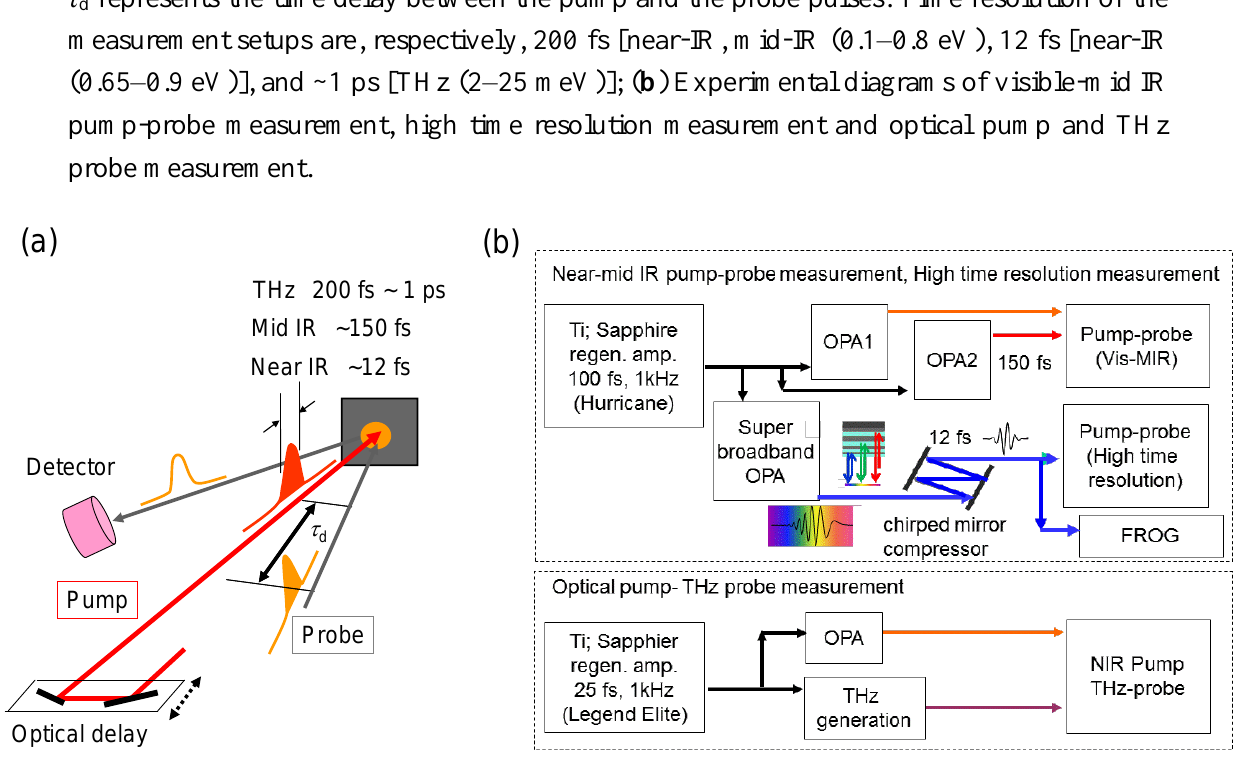
I and of 2 3 and co